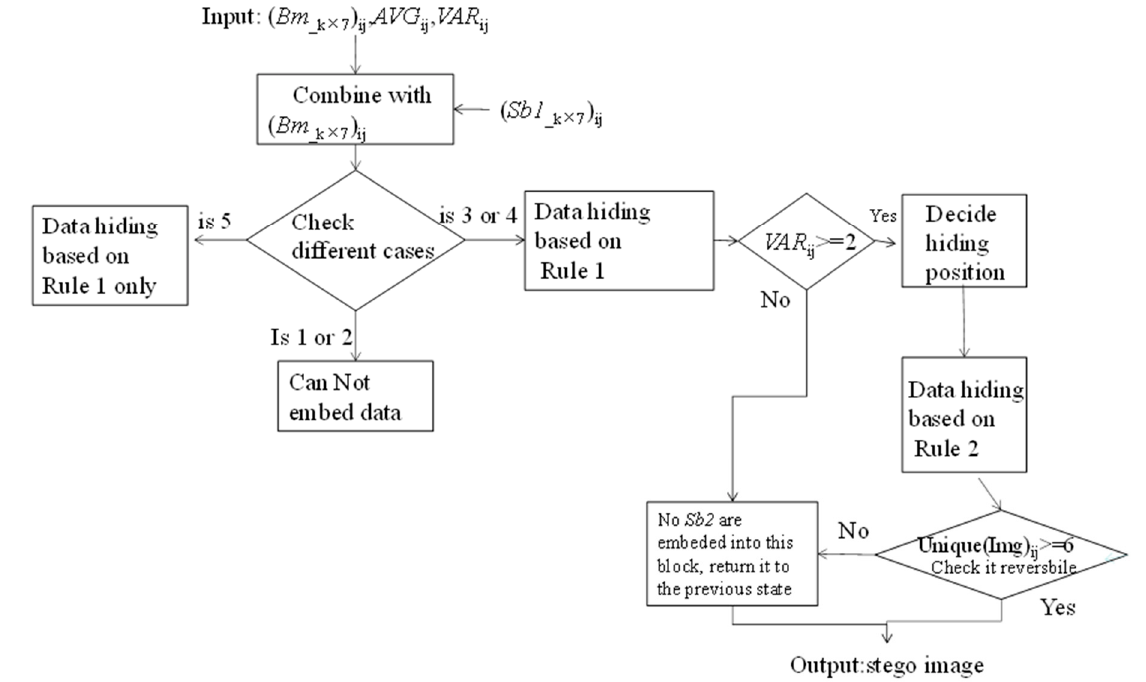
Figure 2. Flowchart for embedding phase. Note: Rule 1 indicates Lin et al.’s data hiding strategy, it is also the hiding strategies adopted in the first layer; Rule 2 is the hiding strategies designed in the second layer.